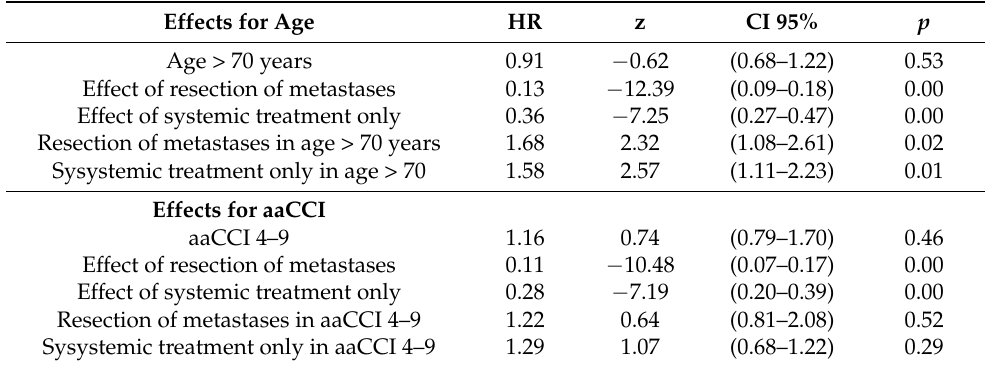
Table A1. Cox Regressions including interaction terms age and treatment modalities and aaCCI and treatment modalities,